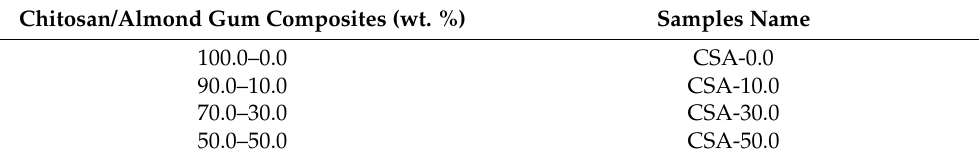
Table 4. The formation ratio of chitosan and almond gum composites. Chitosan/Almond Gum Composites (wt. %)